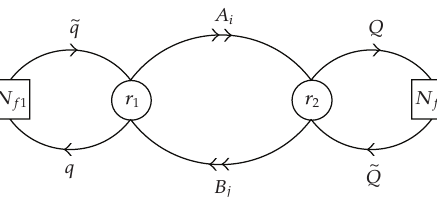
Figure 6: The quiver diagram of the gauge theory. Circles are gauge groups, squares are flavor groups, and arrows are bifundamental chiral superfields. N f 1 and N f 2 sum up to N f .